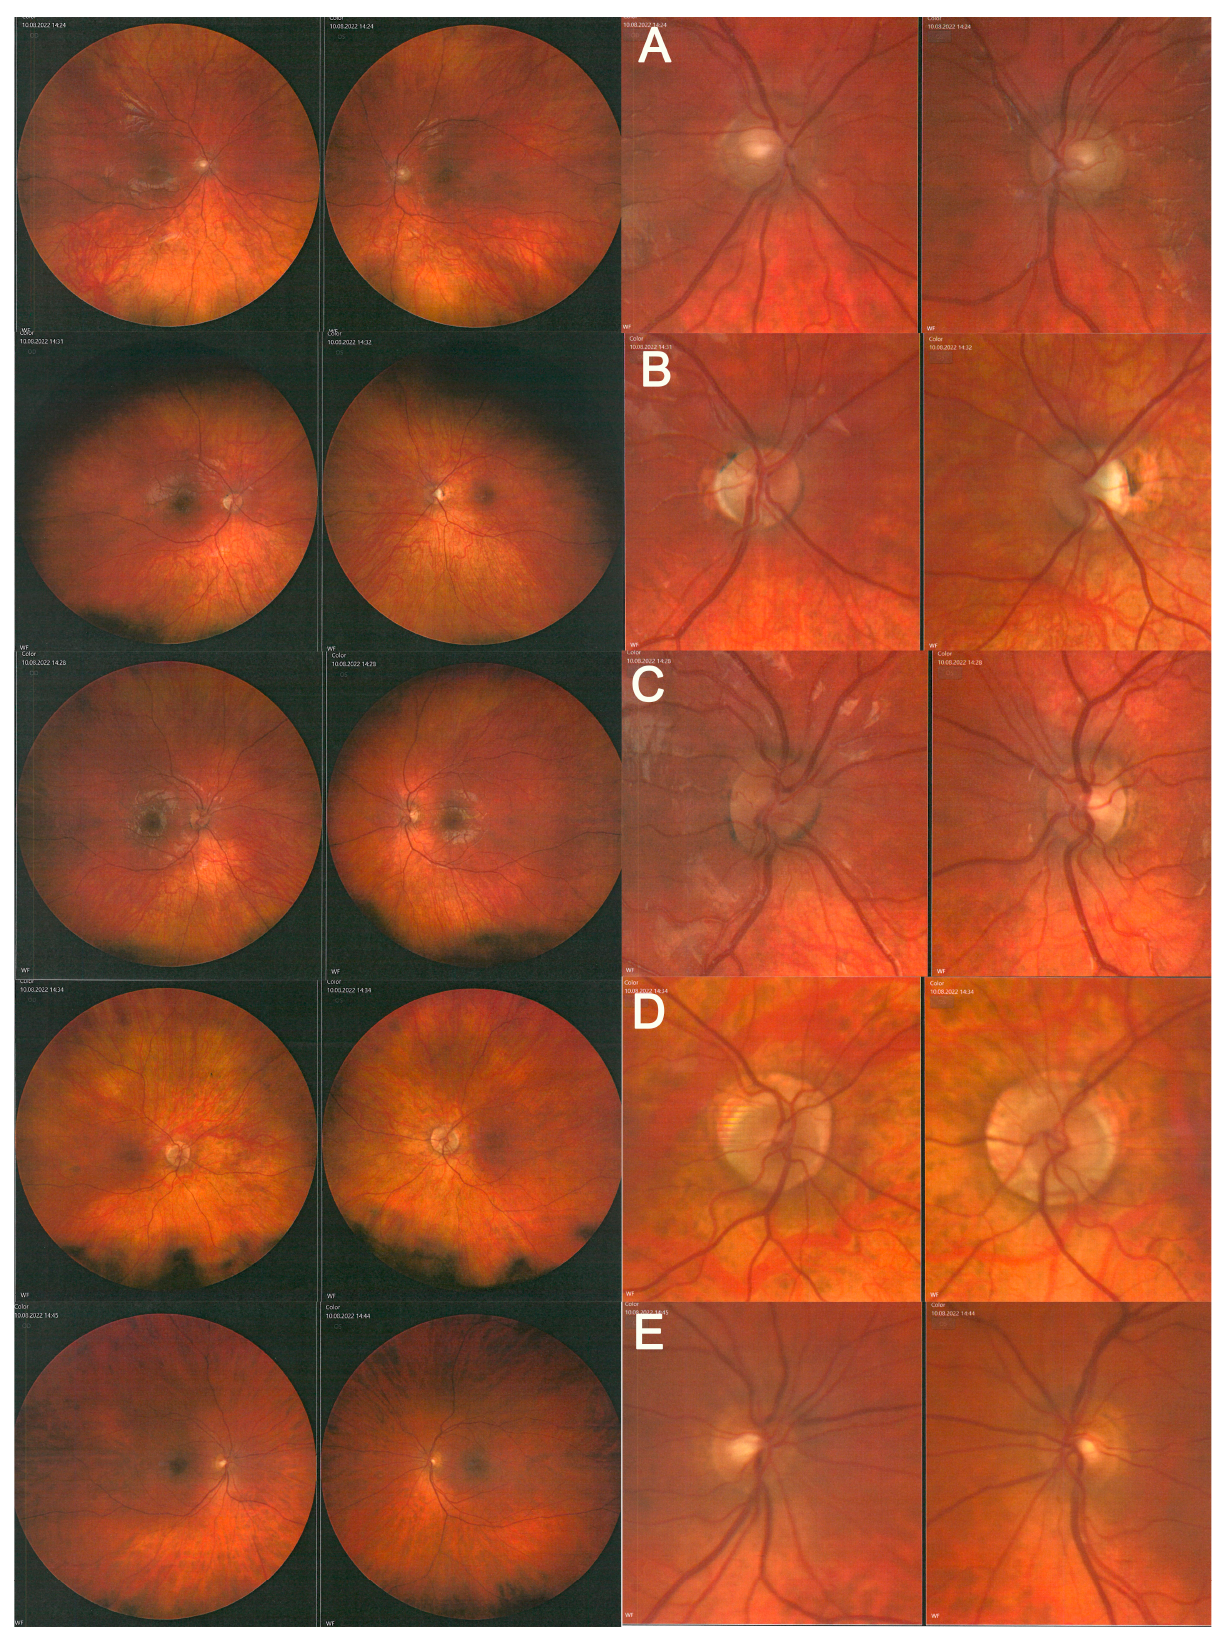
Figure 4. Eye fundus (left) and optic disc (right). ( A )—the middle child; ( B )—the eldest child; ( C )—the youngest child; ( D )—mother; ( E